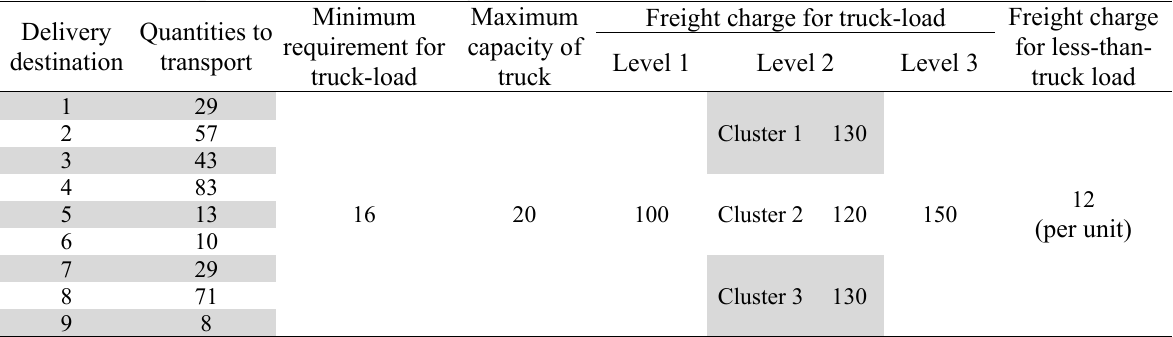
Data for the example 4-level truck loading problem